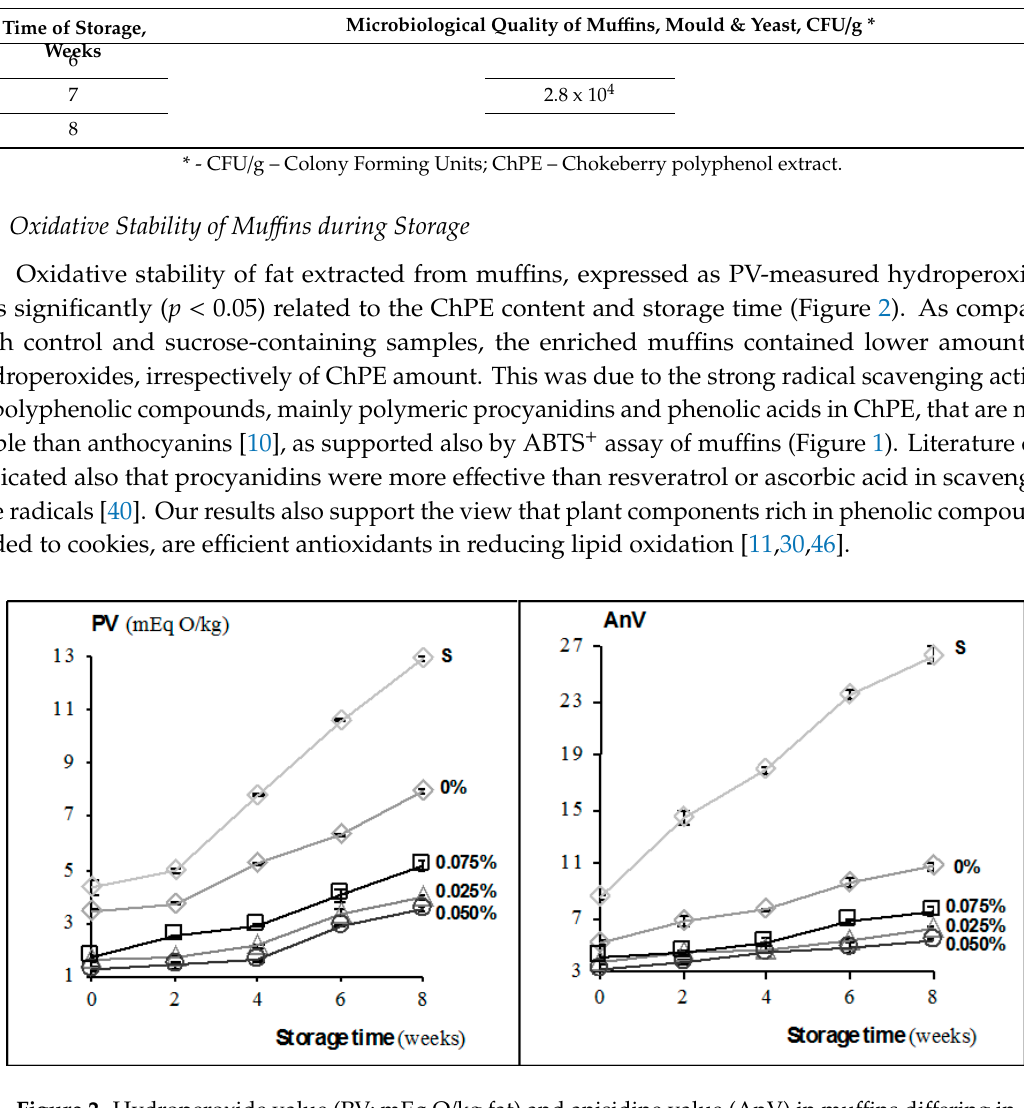
Figure 2. Hydroperoxide value (PV; mEq O/kg fat) and anisidine value (AnV) in muffins differing in ChPE (chokeberry polyphenol extract) content (0–0.075%) and in muffins containing sucrose (S) ChPE (chokeberry polyphenol extract) content (0–0.075%) and in mu ffi ns containing sucrose (S) during during storage (0–8 weeks). storage (0–8